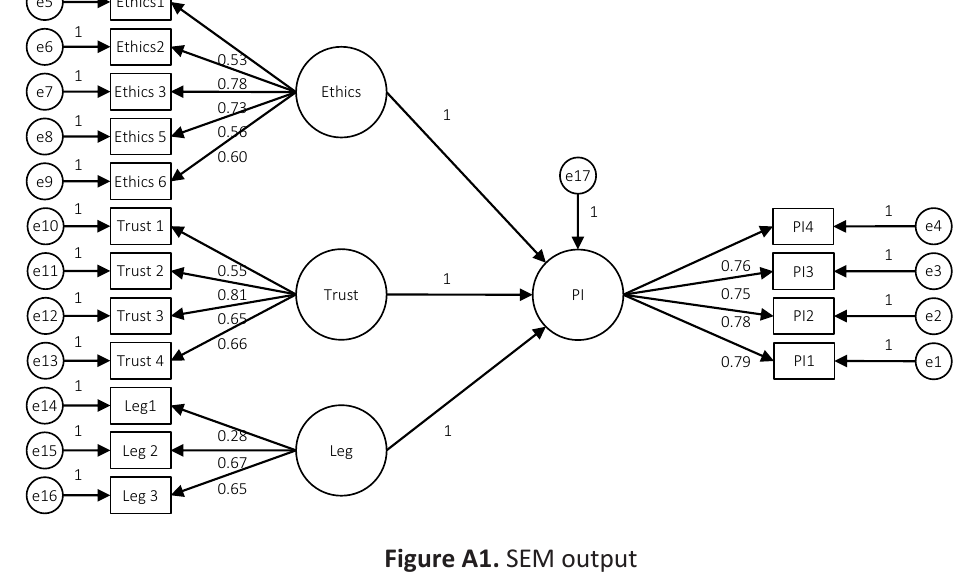
Figure A1. SEM output